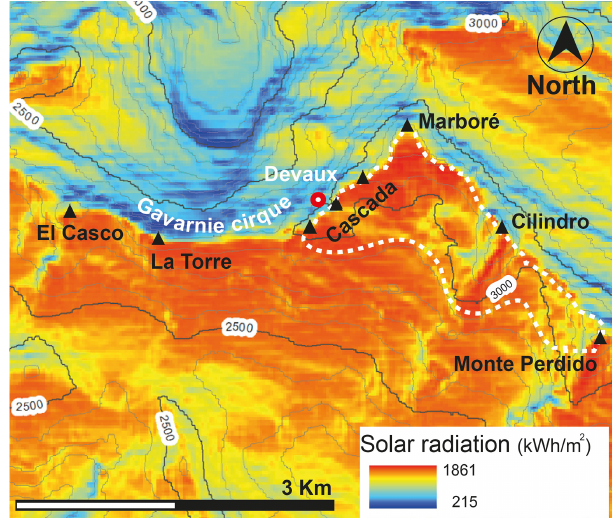
Figure 4. Solar radiation map of the study area. The solar radi- ation anomaly observed in the Gavarnie cirque is explained by its northerly orientation and the cirque morphology. Black triangles in- dicate the main peaks above 3000m. The red-white circle marks Devaux cave, while the dashed white line delineates the approxi- mate